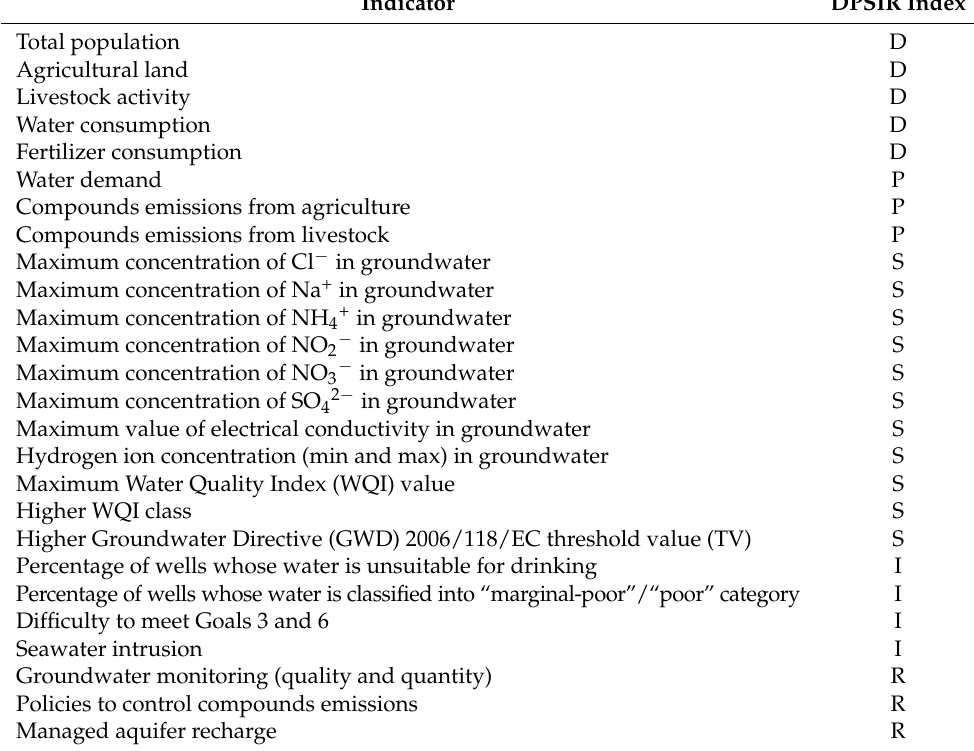
Table 1. Set of indicators for each DPSIR index focused on achieving sustainable development goals in groundwater resources of an agricultural